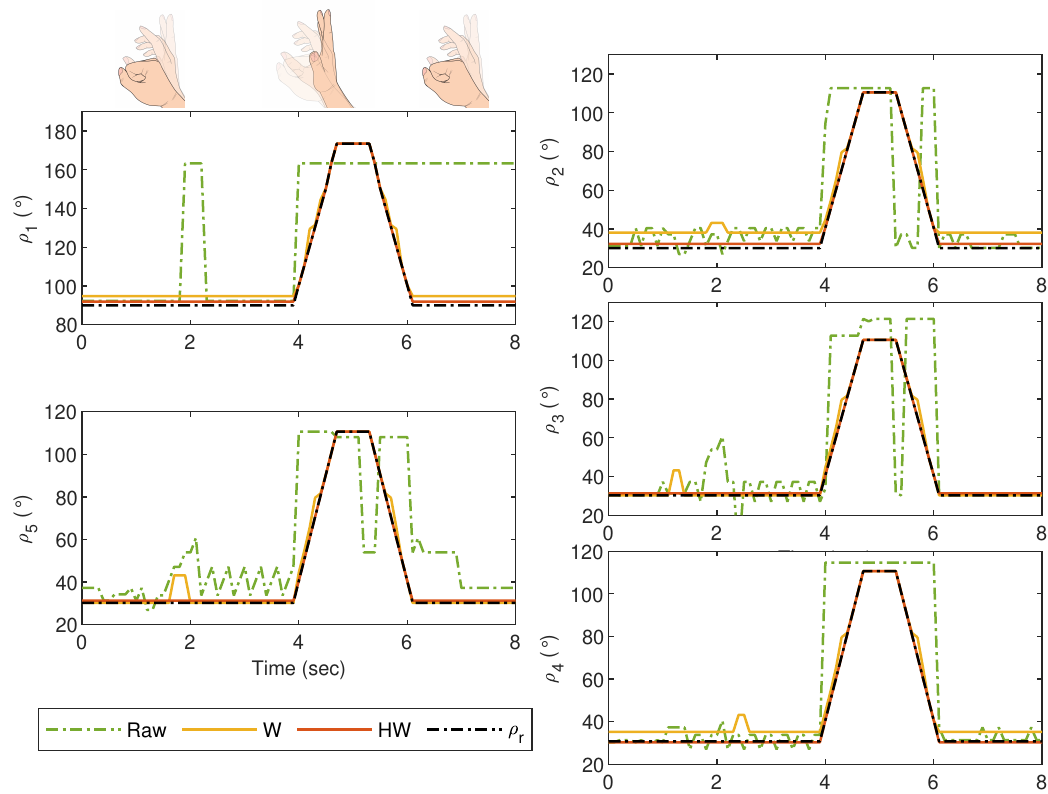
Figure 14. Gesture 1: The mismatch between the glove’s and bionic hand’s goniometry is significantly reduced by using Compensators W and HW. Compensator HW is seen to provide a better response as compared to Compensator W, particularly before t = 4 s and after t = 6 s.